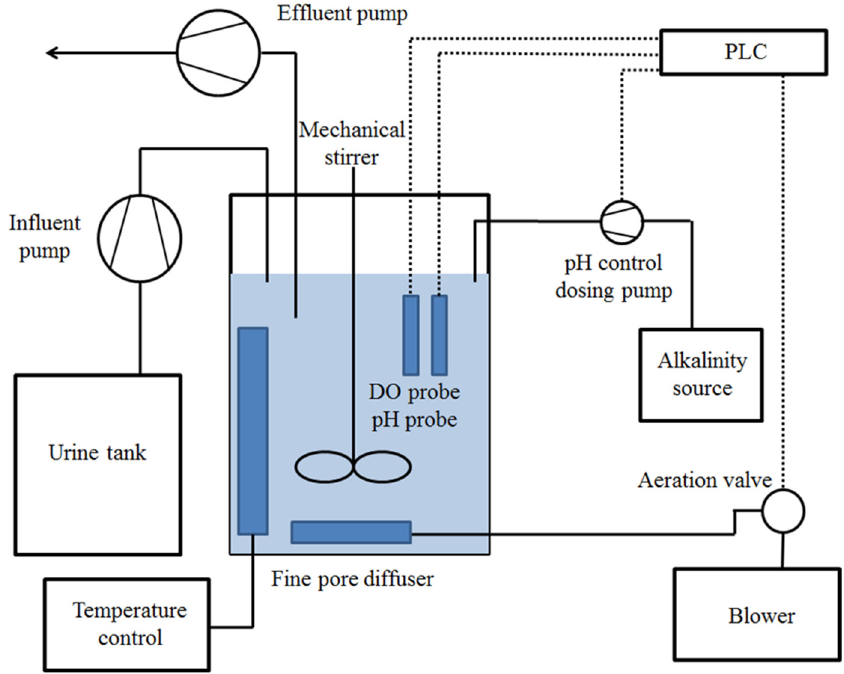
Figure 1. SBR set-up for nitrification of the synthetic urine (for more details see Janiak et al. [28]). PLC—programmable logic controller.